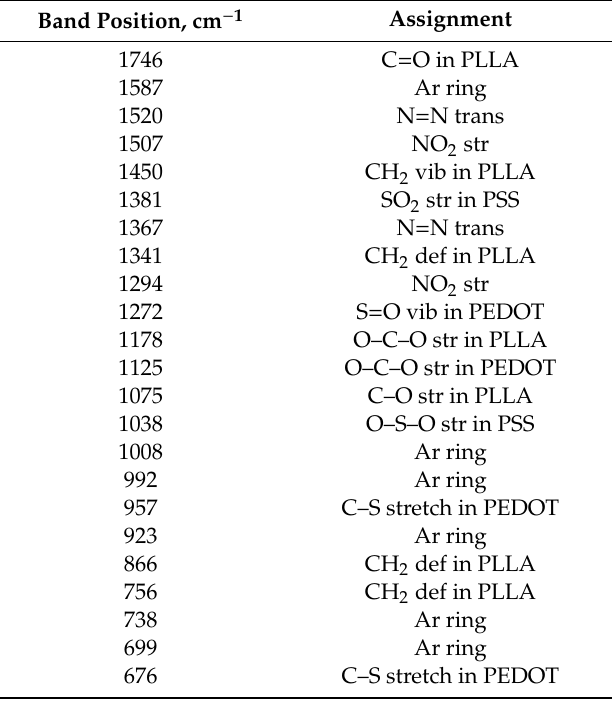
Table 1. Band position of same groups in IR spectra of PEDOT:PSS-NAP samples